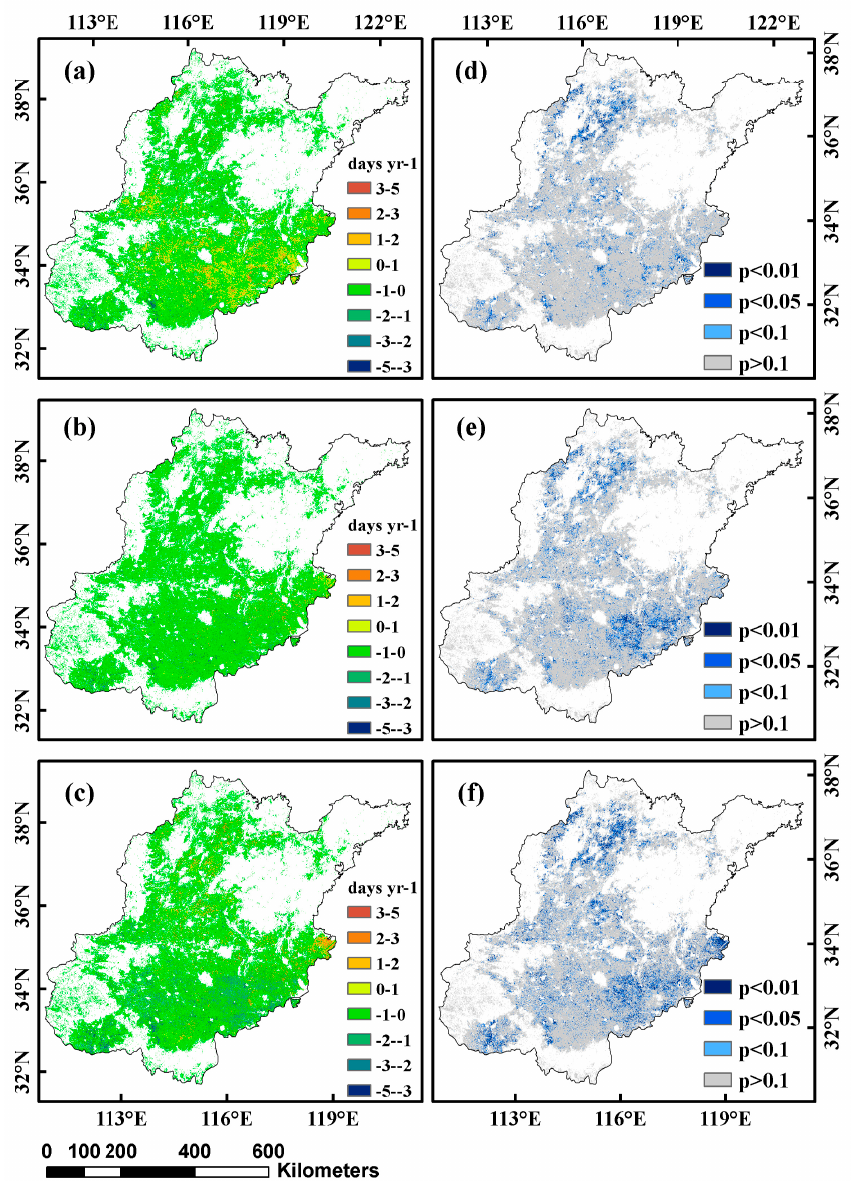
Figure 5. The changes in the HD ( a ), MD ( b ), and LRGP ( c ) during 2003–2018 at di ff erent significance levels ( d – f ). The gray pixels represent where the changes are not significant ( p >